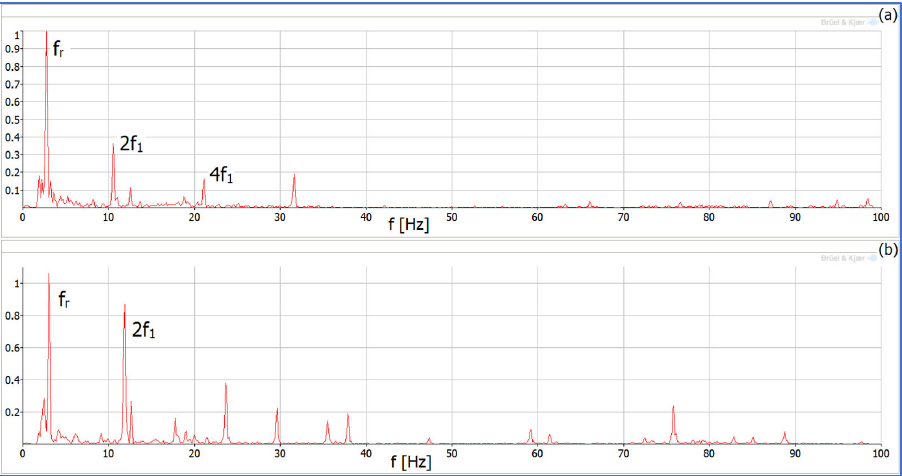
Figure 16. Vibration spectral characteristics for a rotational speed of 150 rpm and under load, where ( a ) characteristic—1h supply, ( b ) characteristic—1h and 3h supply.